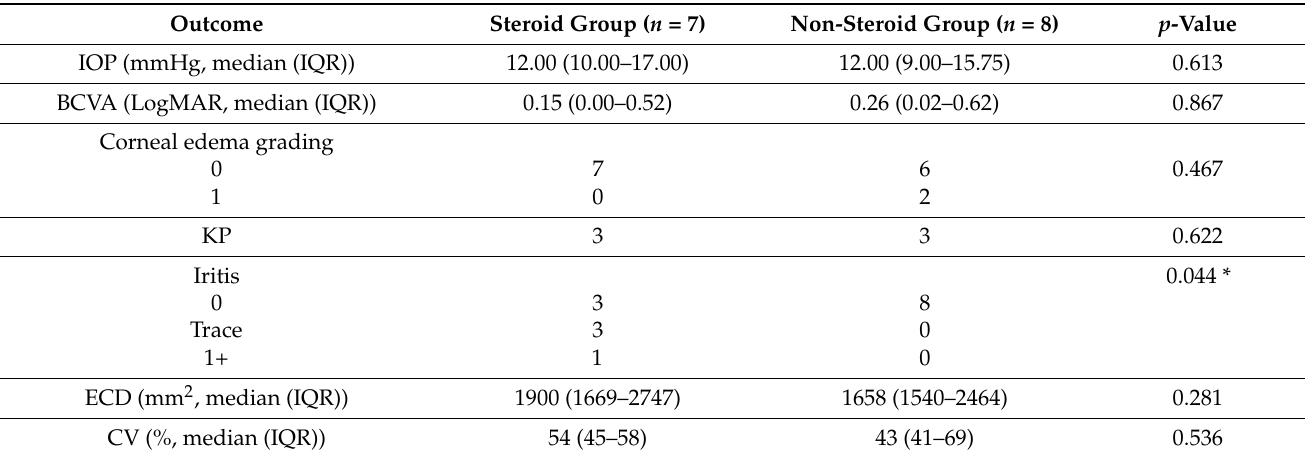
Table 3. The Difference of Post-treatment Outcome Between the Steroid Subgroup and Non- steroid